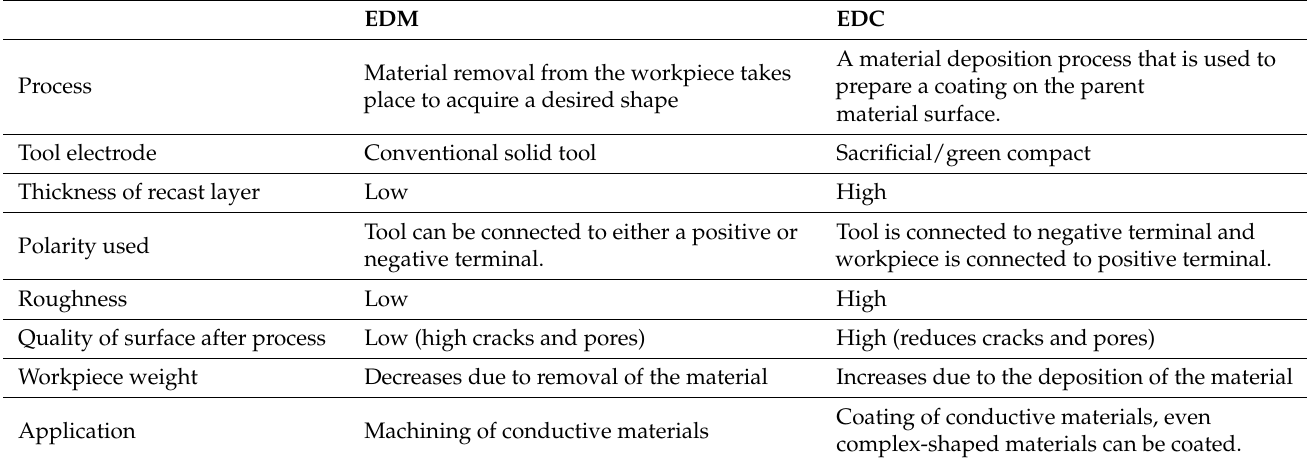
Table 2. Difference between machining and coating.